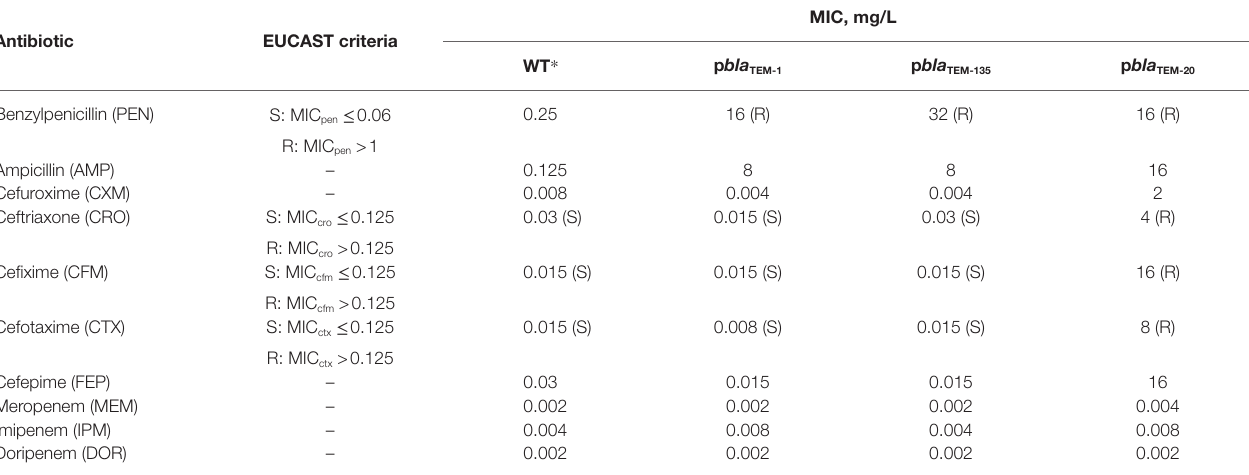
TABLE 1 | Susceptibility of Neisseria gonorrhoeae strains carrying different p bla TEM plasmids to β -lactam antibiotics.